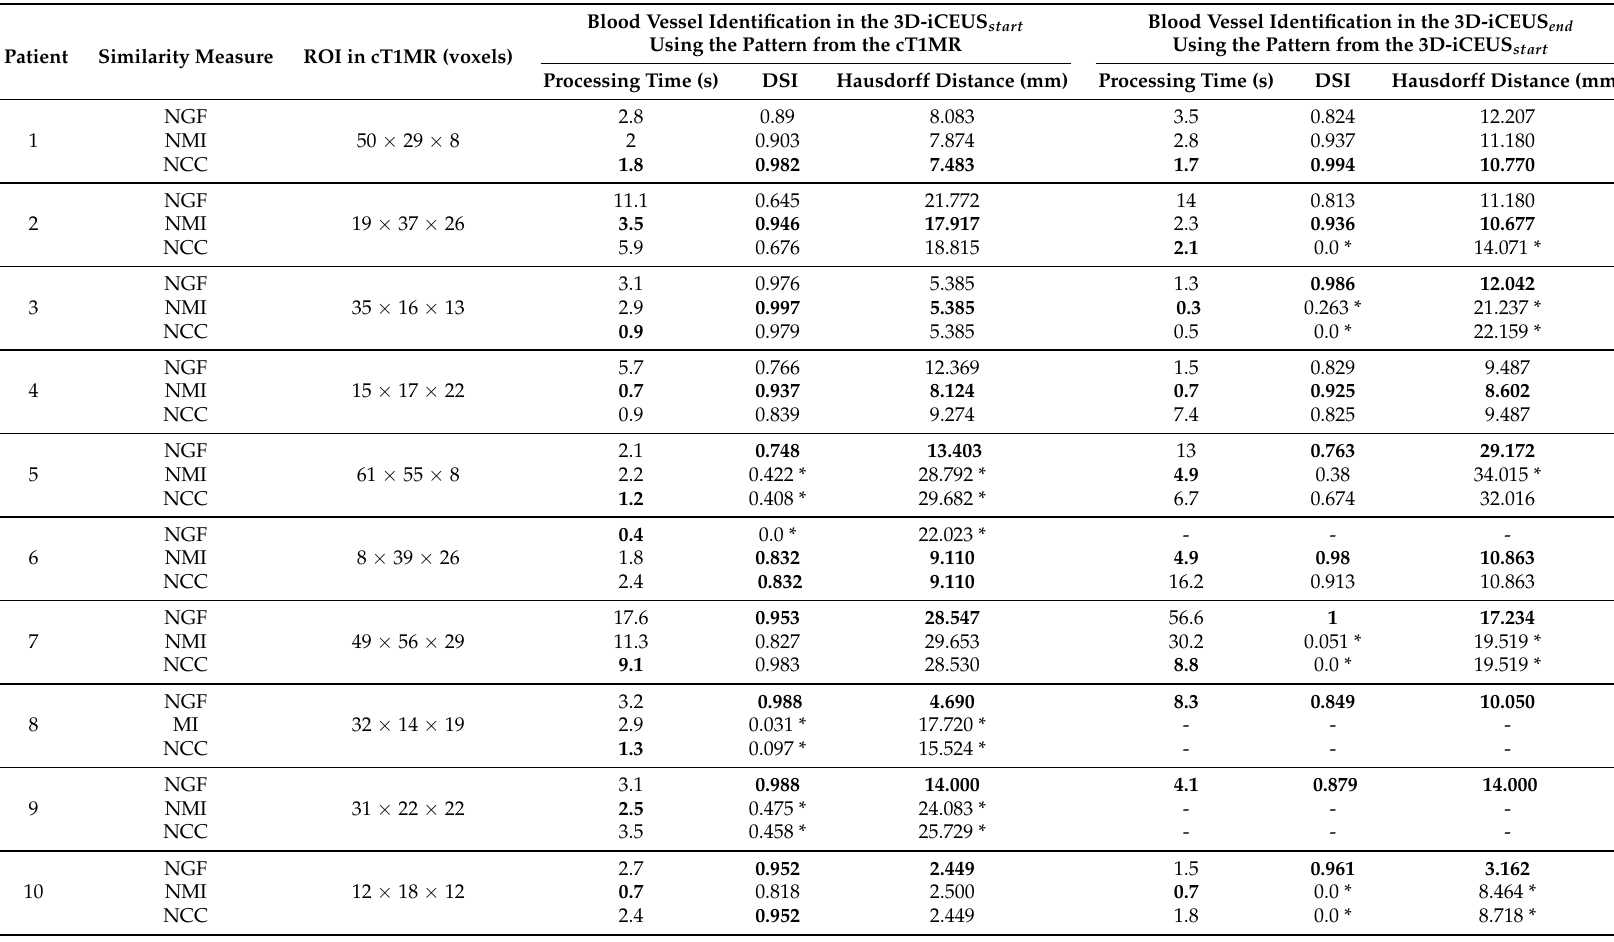
Table 1. Quantitative evaluation of the performance of three different similarity measures in the blood vessel registration algorithm using the DSI and the Hausdorff distance. The values in bold are the best obtained among the three similarity measures. * Indicate that the algorithm failed to find the correct vascular segment.